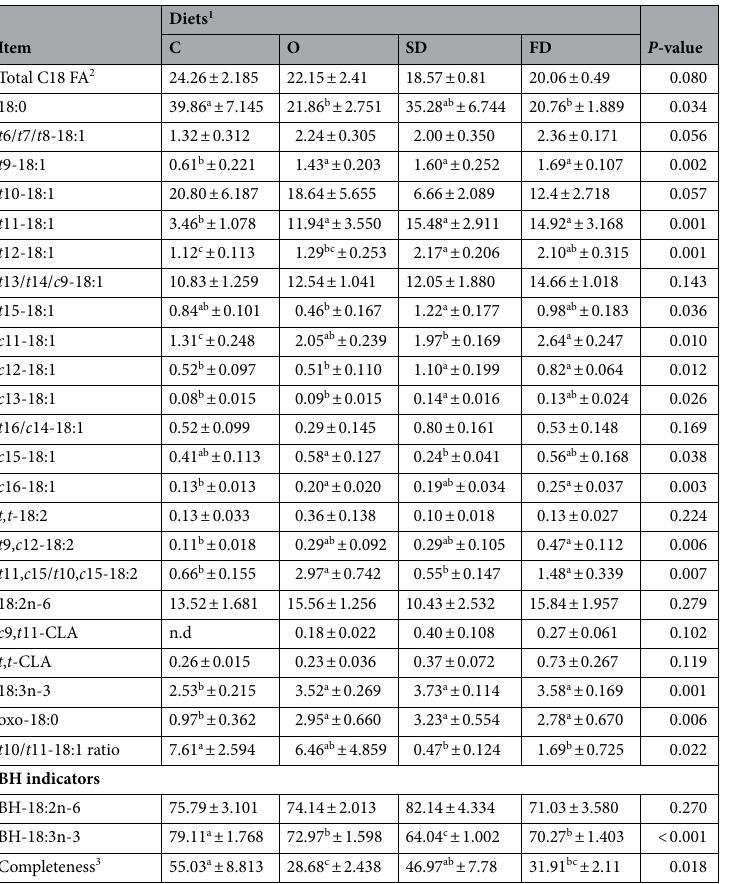
Table 2. Total C18 fatty acid content (mg/g DM) and composition (% of total C18) in the rumen and biohydrogenation (BH) indicators. Values are means ± standard error of the mean. Means within a row with different letters are significantly different (P < 0.05). 1 Diets (or treatments): C, control; O, Control